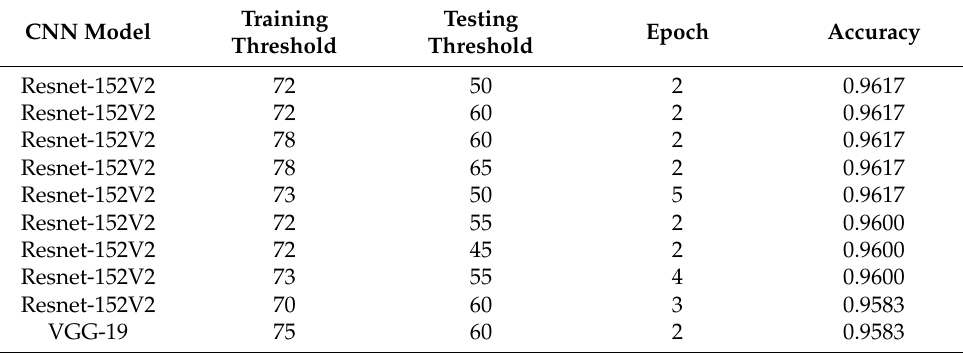
Table 3. Top-10 predicted accuracy in Thr dataset experimental environment.